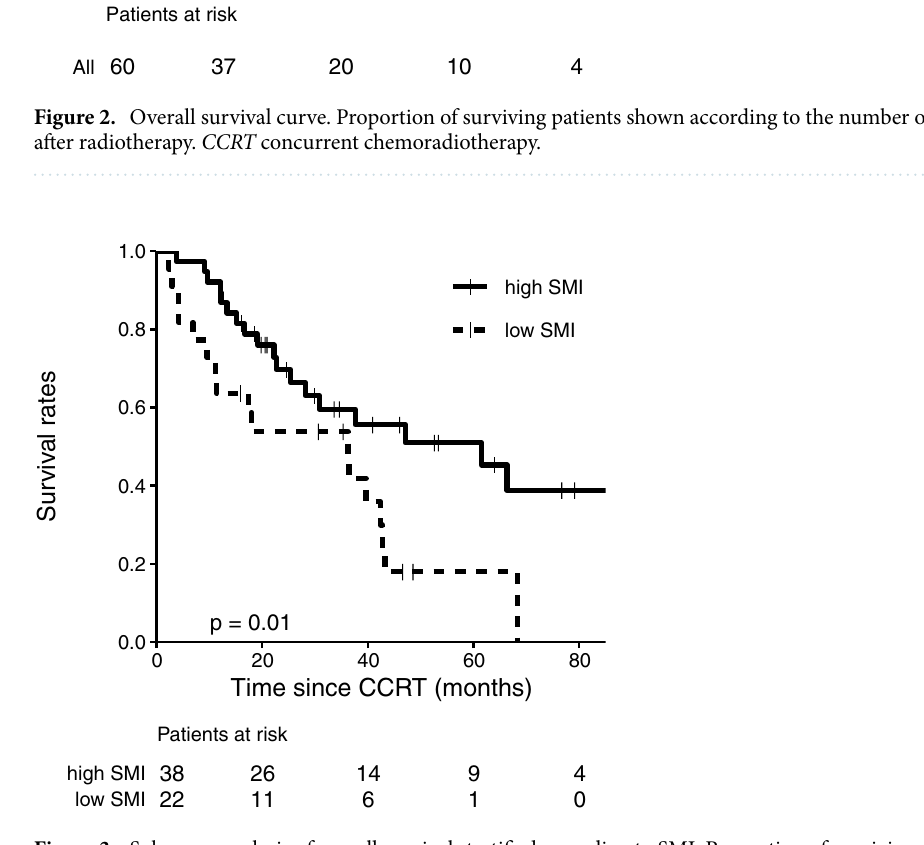
Figure 3. Subgroup analysis of overall survival stratified according to SMI. Proportion of surviving patients shown according to the number of months after radiotherapy, where the filled line represents a low SMI and the dotted line indicates a high SMI. SMI skeletal muscle index, CCRT concurrent